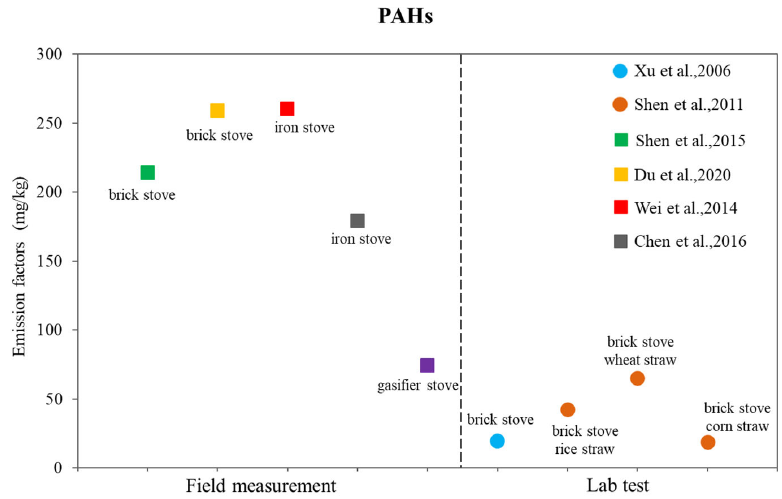
Figure 2. Emission factors of PAHs [23,34,100–103].